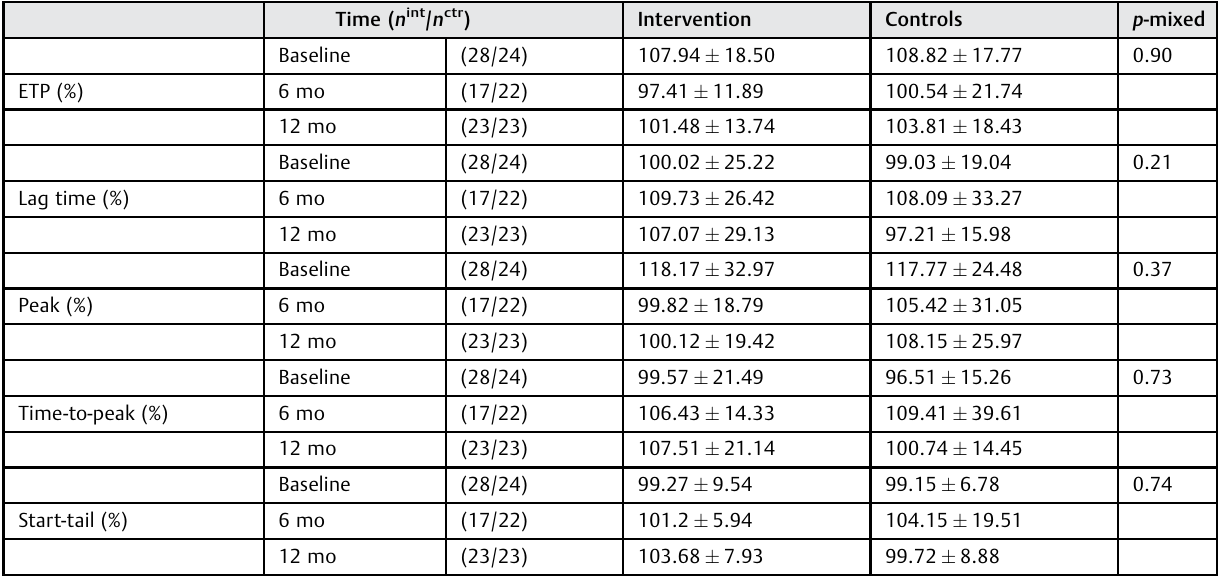
Table 5 Markers of thrombin generation in the two study groups during the study